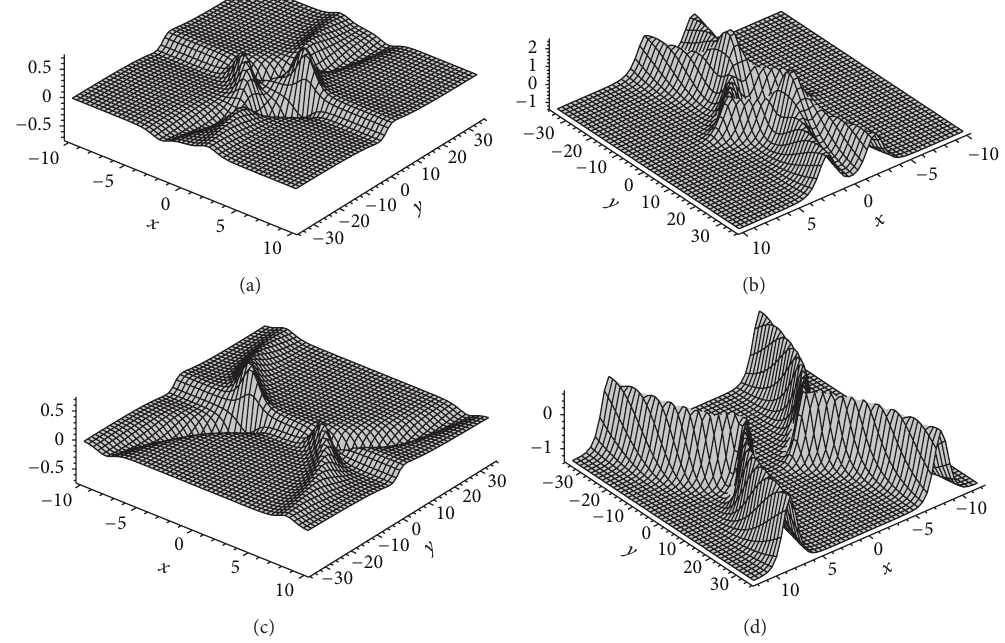
Figure 2: The plots of 𝑢 1 and V 1 in Family 1, with parameters 𝐹 1 (𝑡) = 𝑡 , 𝐹 2 (𝑦) = ln (𝑦 2 + 10) , 𝐶 1 = 𝐶 3 = 1 , 𝐶 5 = −2 , 𝐶 2 = 𝐶 4 = 𝐶 6 = 0 , 𝜙 = tanh, and 𝜓 = tanh at ((a) and (b)) 𝑡 = −5 and ((c) and (d)) 𝑡 = 1